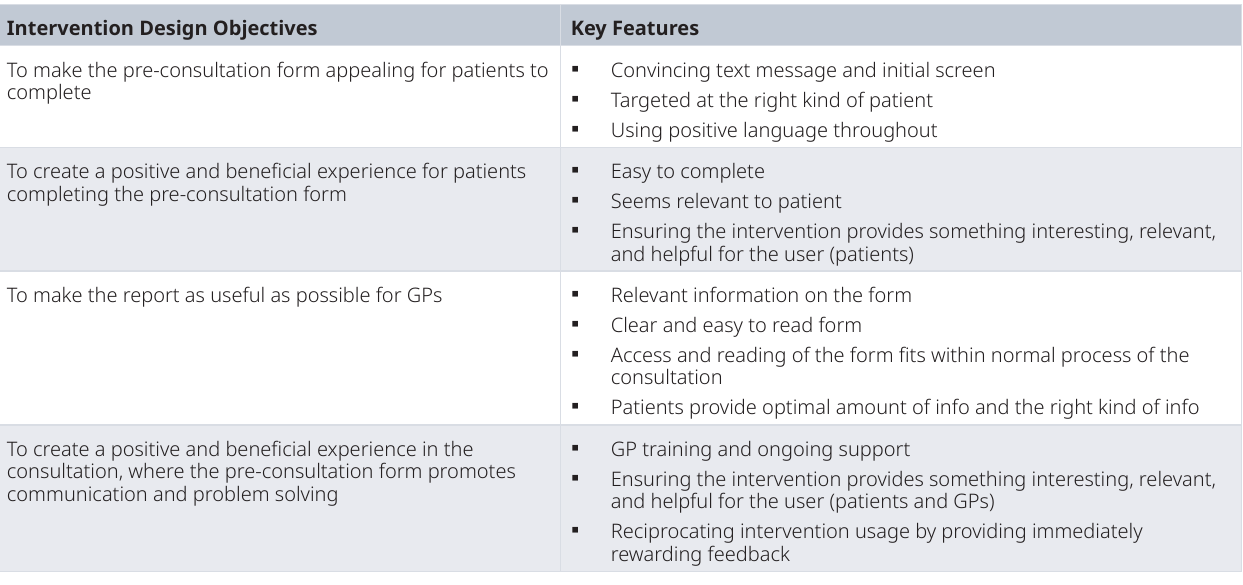
Table 4. Guiding principles – pre-consultation form. Intervention Design Objectives